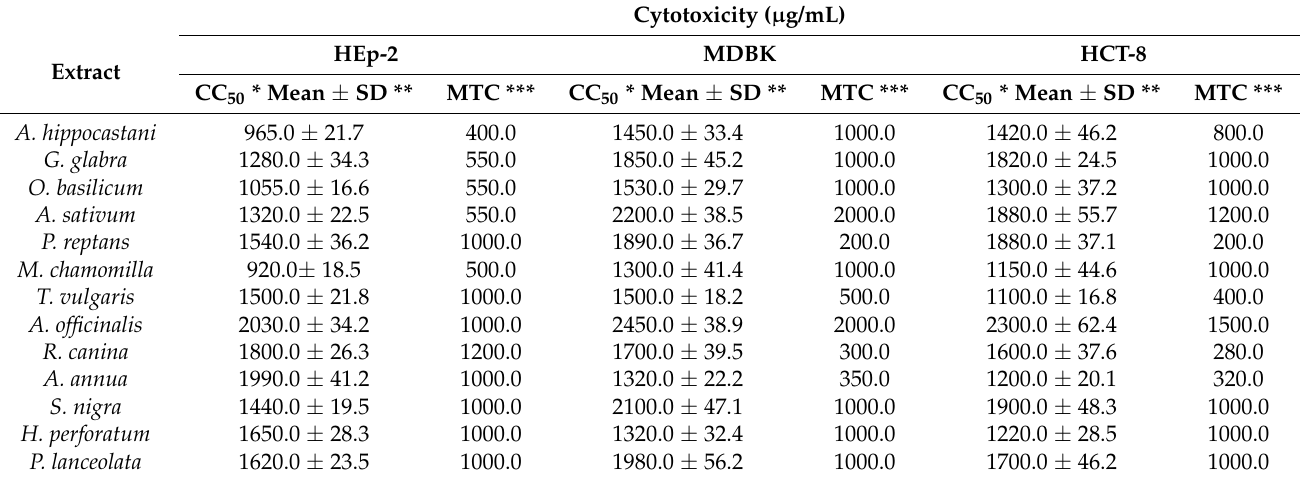
Table 2. Cytotoxicity of extracts against HEp-2, MDBK, and HCT-8 cell lines.